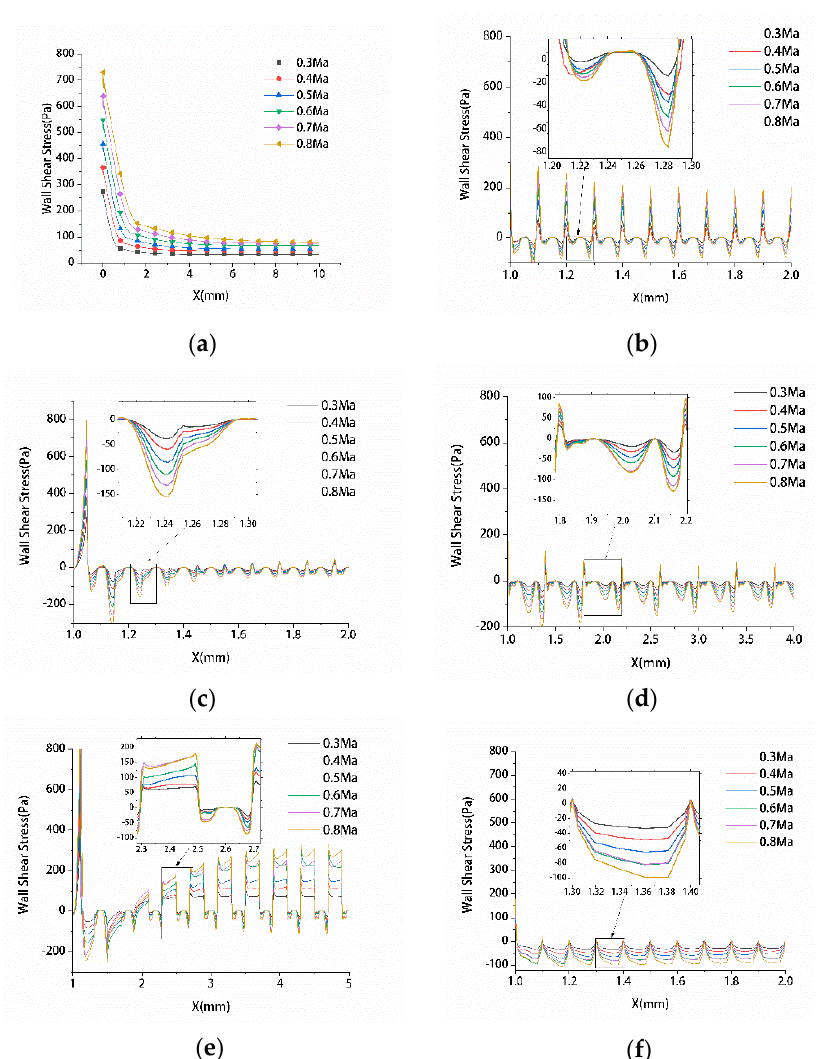
Figure 4. The wall shear stress of incoming flow direction. ( a )The smooth flat plate, ( b ) the triangular concave grooves, ( c ) the triangular protrusions, ( d ) the trapezoidal concave grooves, ( e ) the trapezoidal protrusions, and ( f ) the circular concave